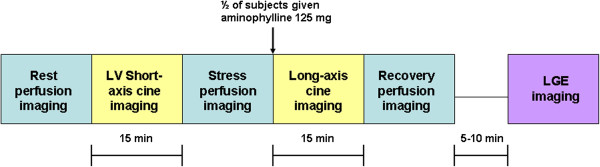
CMR protocol. Perfusion imaging sequences are separated by 15-min intervals as shown.